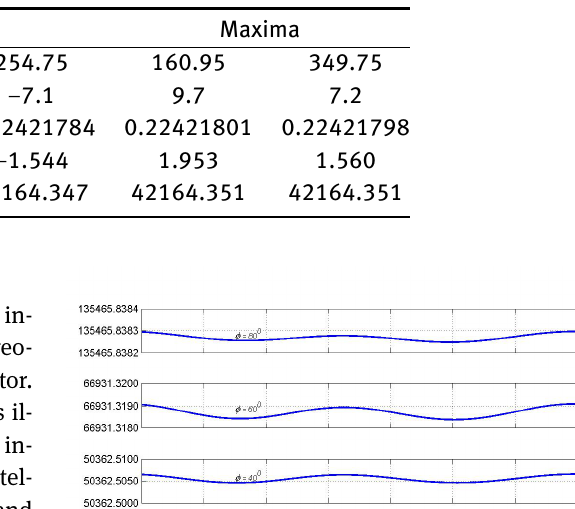
Table 2: The radius and Earth’s gravity acceleration at the extreme points.